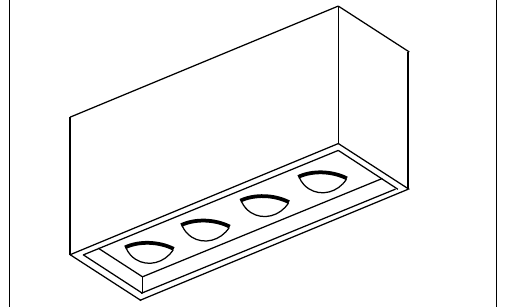
Figure 8. A sample LED luminaire with lenses.